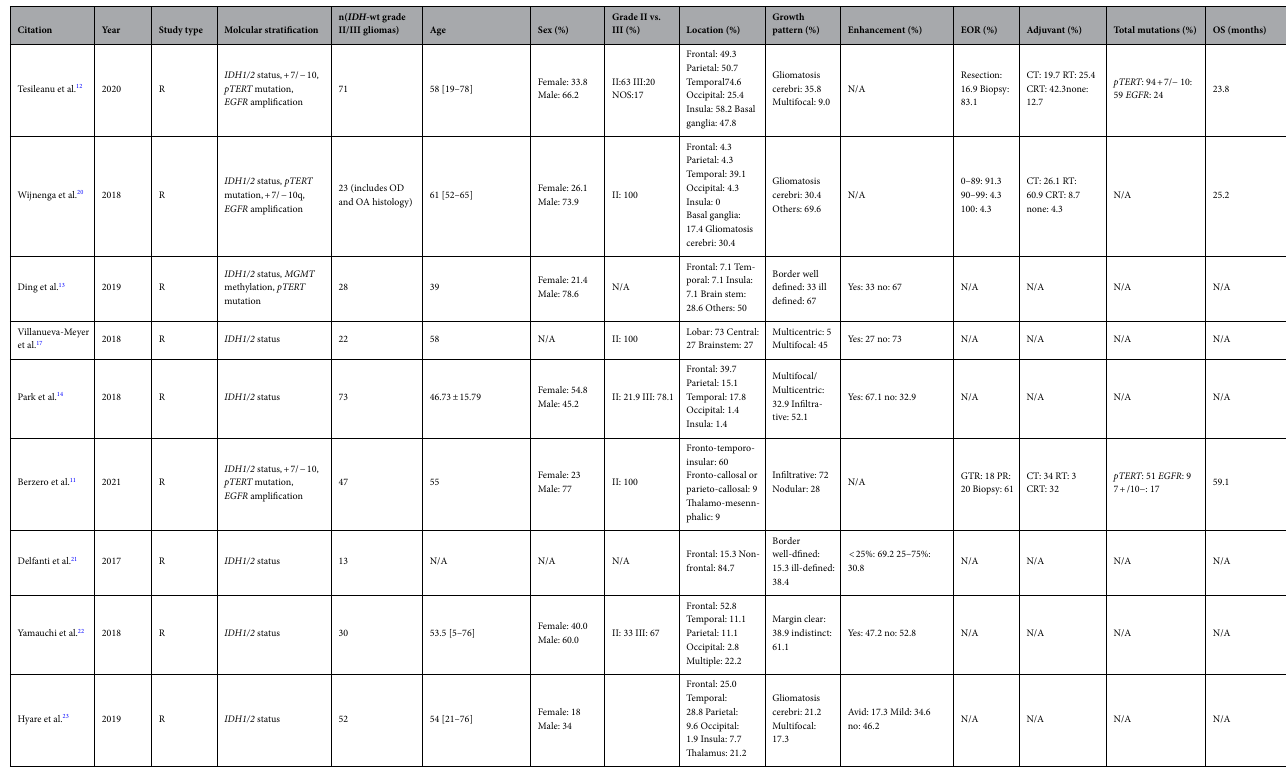
Table 3. Literatures about IDH wild-type lower grade gliomas. IDH isocitrate dehydrogenase, wt wild-type, EOR extent of resection, OS overall survival, R retrospective study, pTERT telomerase reverse transcriptase promoter, EGFR epidermal growth factor receptor, NOS not otherwise specified, N/A not available, CT chemotherapy, RT radiotherapy, CRT chemoradiotherapy, OD oligodendroglioma, OA oligoastrocytoma, GTR gross total resection, PR partial